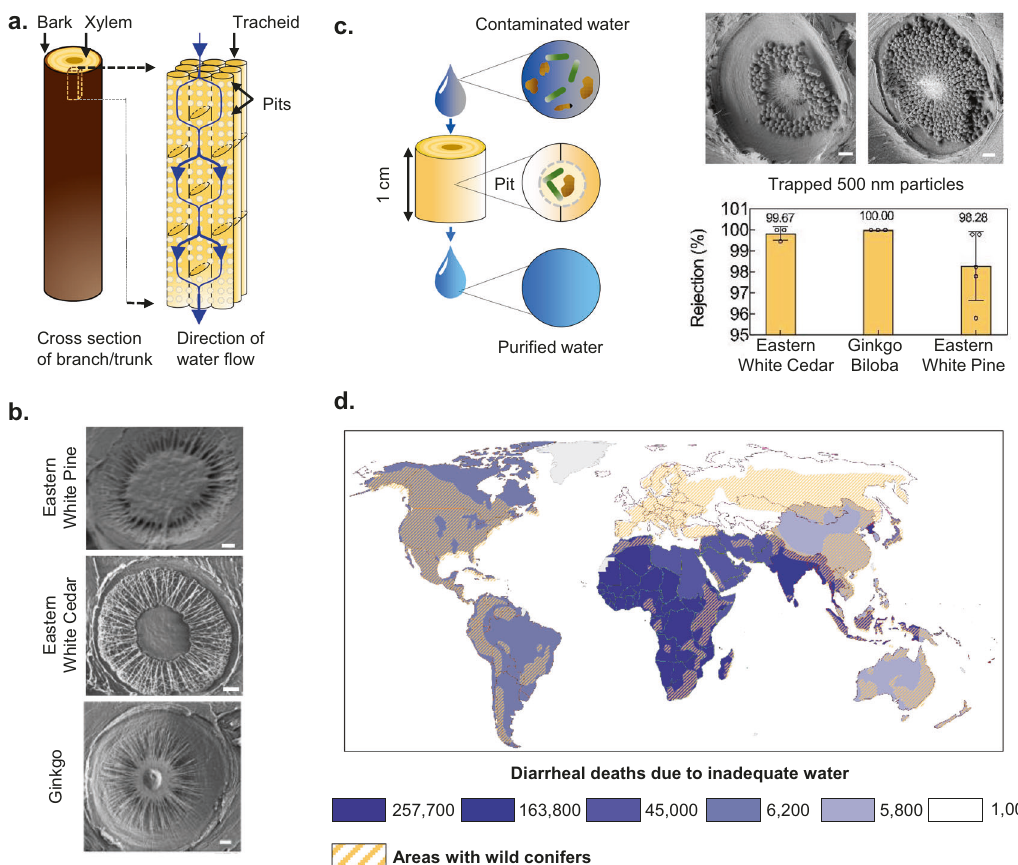
Fig. 1 Gymnosperm xylem water fi lter. a Illustration of gymnosperm xylem structure. b Scanning Electron Microscopy (SEM) images of pit membranes in different gymnosperms. Scale bar, 1 μ m. c Schematic depiction and SEM images of fi ltration of 500-nm particles by xylem pit membranes in a section of a branch (ginkgo, 1-cm diameter, 0.25-inch thickness). Scale bar, 1 μ m. The bar graph shows rejection of 500-nm particles by fresh xylem fi lters made from different tree species (1-cm diameter, 0.25-inch thickness). Mean ± s.d.; n = 3 different fi lters; see “ Methods ” for details). d The global distribution of wild conifers overlaid on the number of diarrheal deaths caused by inadequate (contaminated) water in 2016 within each colored region illustrates the potential for scaling and impact of xylem-based fi ltration devices. The numbers in the legend represent the total diarrheal deaths for the regions shaded in the same color (world map by Diana Beltekien adapted from https://ourworldindata.org/world-region-map-de fi nitions under Creative Commons BY license; see “ Methods ” for fi gure construction details and